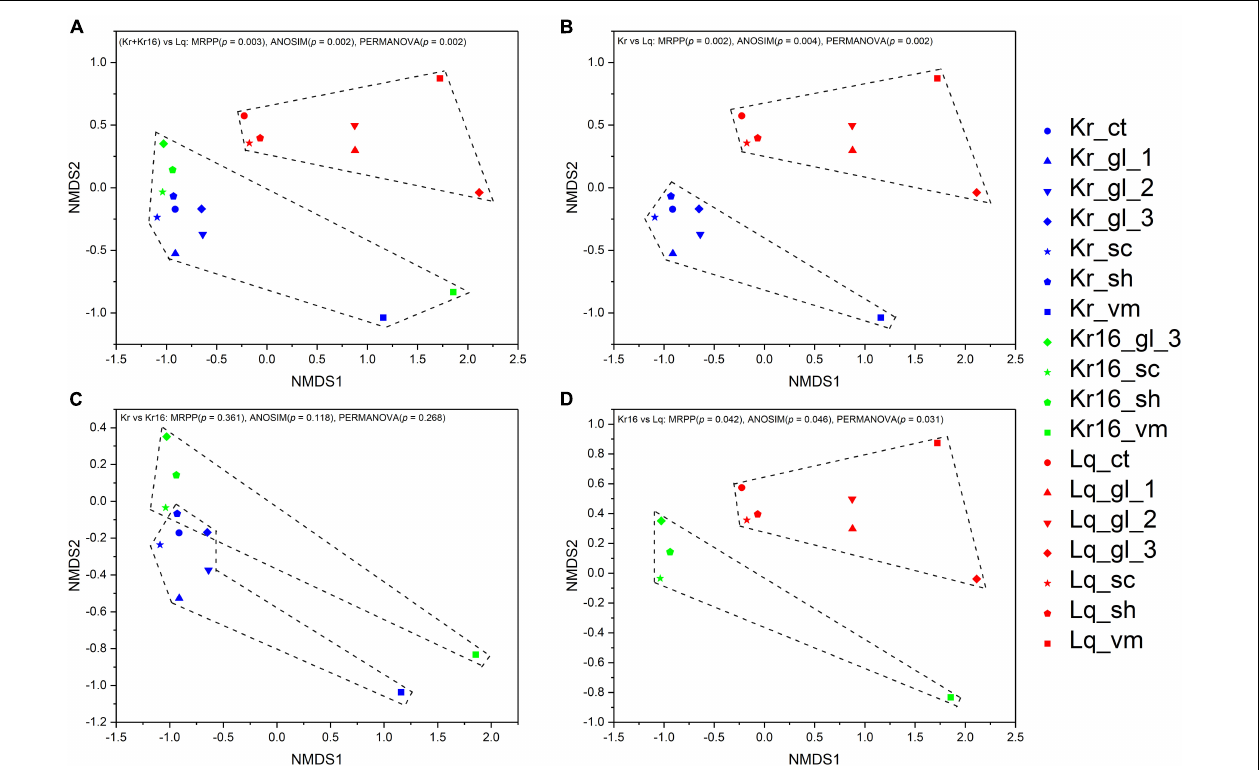
FIGURE 2 | NMDS analysis of the microbial communities separated the samples into two principal groups, one composed of the samples of SFSs collected from the Kairei vent field, and another group composed of SFS samples collected from the Longqi vent field (A) . Although the samples of Kr and Kr16 grouped together, they were in a loose pattern with no significant difference (C) . However, the microbial community structures of Kr and Kr16 were clearly separated from the microbial community of Lq (B,D) . The results based on the OTUs